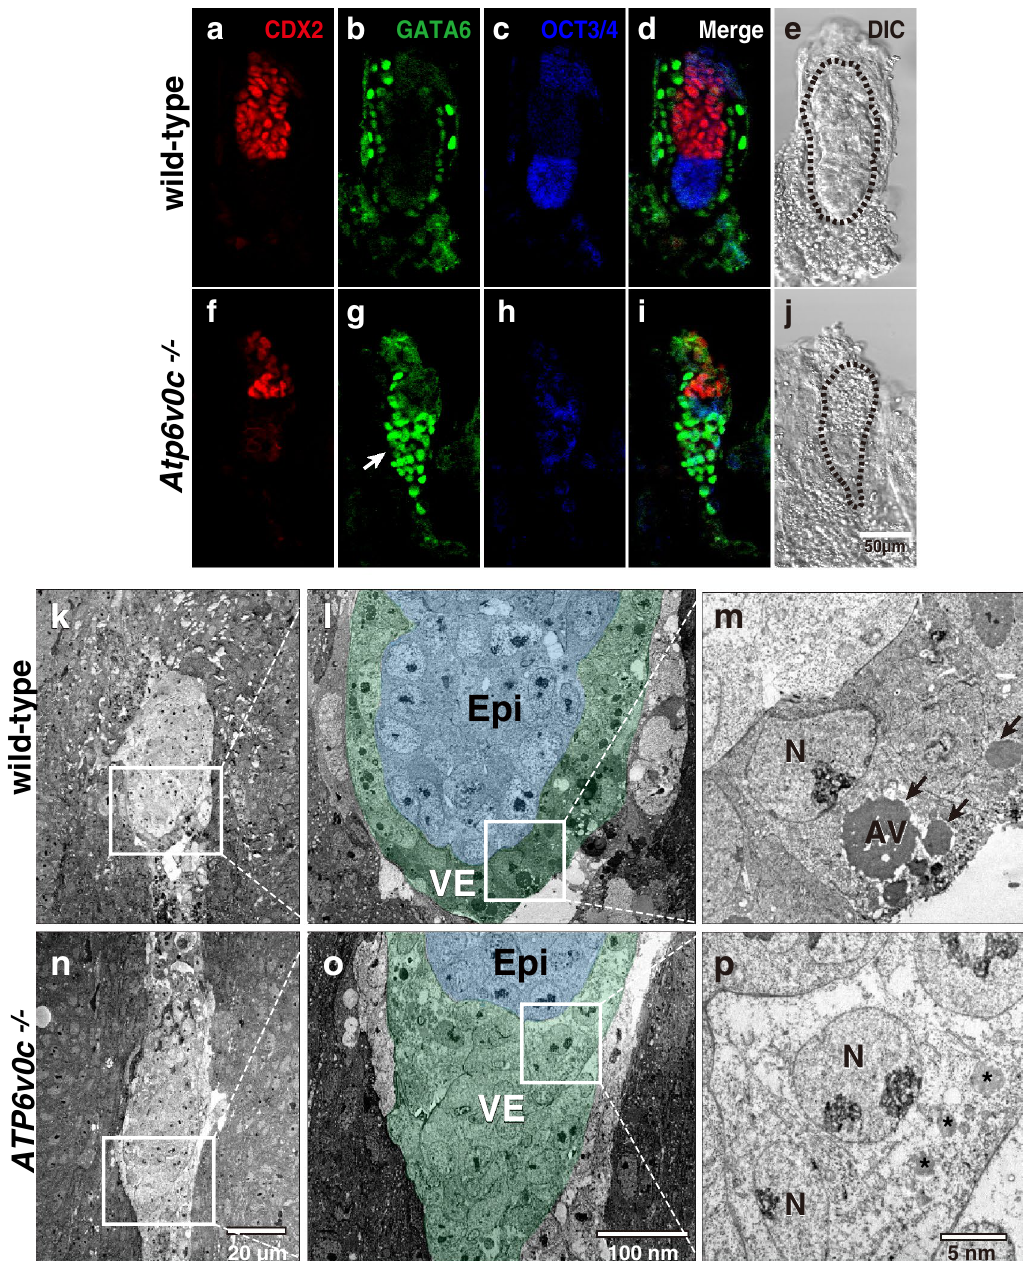
Figure 1. Immunofluorescence analysis of E5.2 embryos with various differentiation markers. The extraembryonic ectoderm (ExE) marker CDX2 (red, a and f ), endoderm marker GATA6 (green, b and g ), and epiblast (Epi) marker OCT3/4 (blue, c and h ) are used. The merged ( d and i ) and DIC images (e and j) are also shown. The endoderm ExE and epiblast differentiation was observed in Atp6v0c mutant embryos, but their size reduced ( f to j ). The layer of GATA6-positive cells often appeared as a clump (white arrow). The outlines of embryos are indicated with a broken line. Representative images of wild-type (n = 18) and mutant (n = 3) embryos were shown. Scale bar, 50 µm. Transmission electron microscopy of E5.5 decidua ( k to p ). The pseudocoloured images of the visceral endoderm (VE) and Epi are shown ( l and o ). Apical vacuoles (AVs) are shown by black arrows ( m ). N; nucleus. The fragmented vesicular structures in mutant embryo are shown by asterisks. Scale bars are indicated in the image panels. Wild-type (n = 3) and mutant embryos (n =